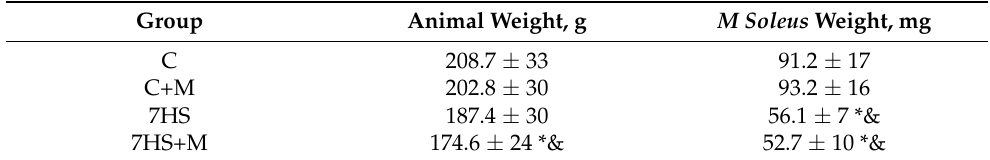
Table 1. Body weights and m soleus weights of the experimental animals. *—significant differences of C group. &—significant differences of C+M group ( p <